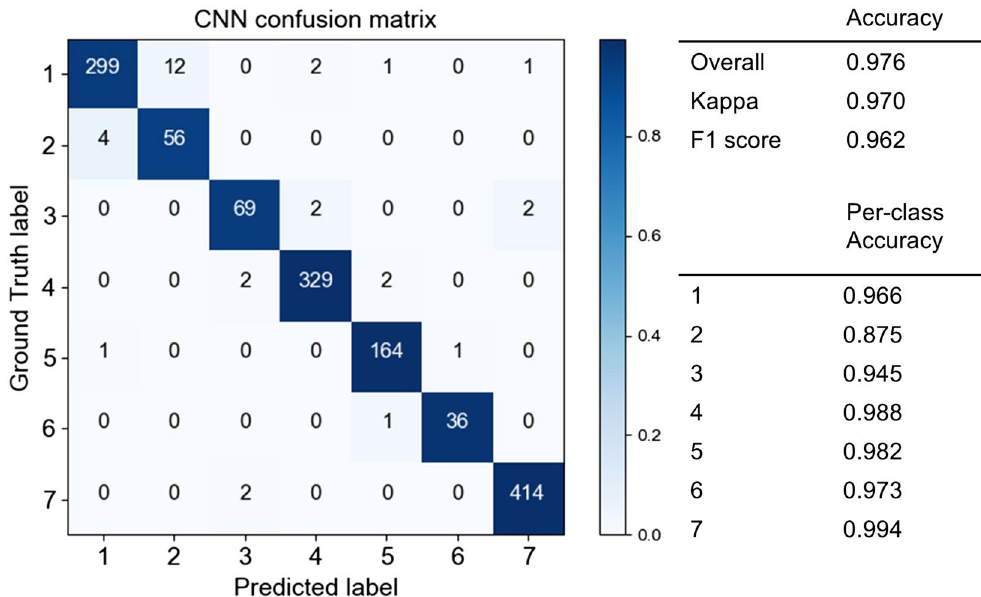
Figure 6. Confusion matrix of CNN in the fall season (Model 1). The vertical axis is the ground truth and the horizontal axis the model prediction. The number in each cell indicates the number of classified images; each cell is coloured according to the percentage of the number of images in each class. (Class 1: deciduous broad- leaved tree; 2: deciduous coniferous tree; 3: evergreen broad-leaved tree; 4: Chamaecyparis obtuse ; 5: Pinus elliottii or Pinus taeda ; 6: Pinus strobus ; 7: non-forest).